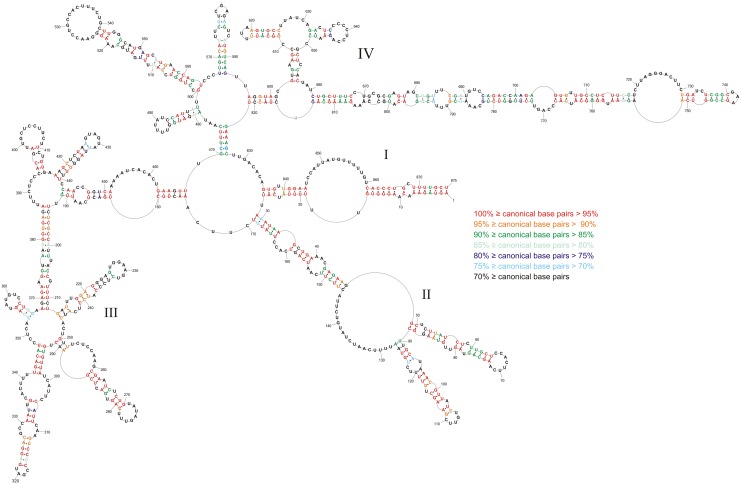
Conservation of vRNA8 self -folding in type A viruses.Colors indicate percentage of canonical base pairing preserved across vRNA segment 8 of type A strains. Compensating changes occur for base pairs U60/G77, C63/G74, C99/G117, C661/G814, C664/G811, U667/A808, C694/G782, A697/U779, and A703/U773. The numbering of vRNA8 is from its 5' end.